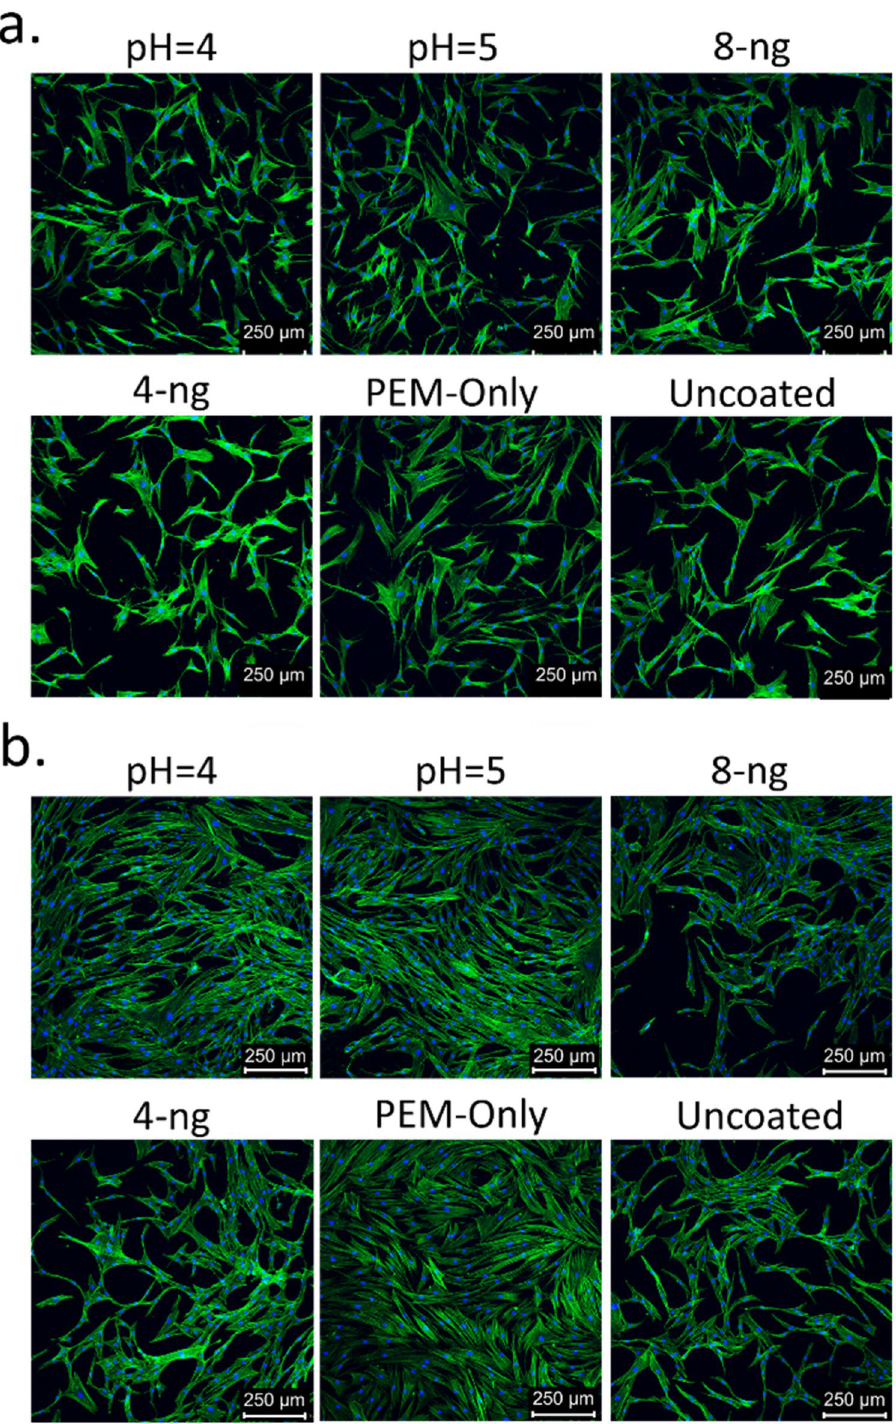
Figure 5. Representative images of cells stained with Hoechst 33342 (blue) and phalloidin coupled with Alexa Fluor 488 (green) at ( a ) 2 days and ( b ) 4 days of culture time. pH values refer to PEM assembly conditions. Cells were seeded at an initial density of 5000 cells/cm 2 in IMDM with 1%